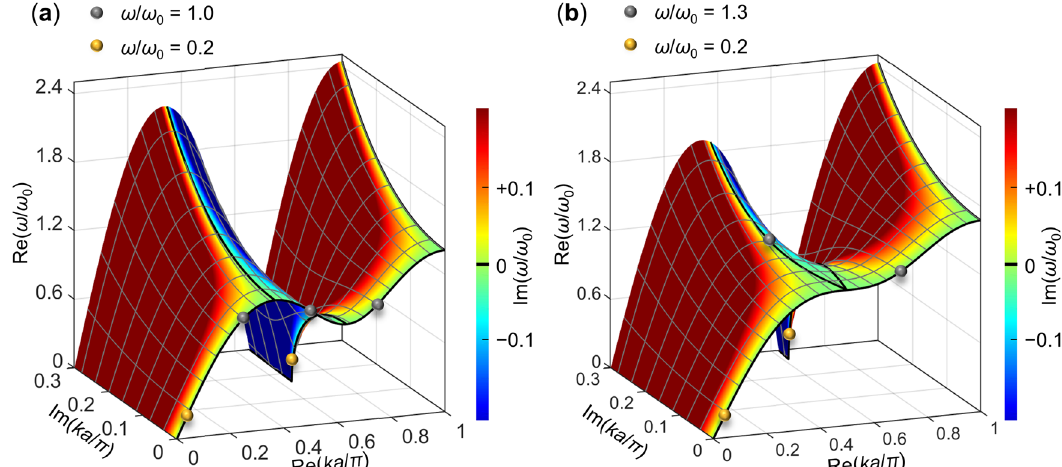
Fig. 2 Dispersion relations of the mass-and-spring model. a Surface plot of real component of frequency ω versus the real and the imaginary components of the wavenumber k following Eq. (5). For the conditions discussed in this paper, the angular frequency ω is purely real. The wavenumber k is also purely real for a Bloch-periodic solution of an in fi nite periodic model. For a fi nite-thickness slab (see Fig. 1b), evanescent modes can play a role and the imaginary part of k is generally not zero. The imaginary part of the complex-valued angular frequency ω is shown by the false-color scale. Only the positive parts of the real and imaginary components of the wavenumber are shown here as the corresponding negative parts can be obtained by mirror symmetry. The four highlighted black lines on the surface lead to purely real angular frequency ω . Among them, one corresponds to purely real wavenumber and the other three correspond to complex wavenumbers in the range of Re ð k Þ > 0. For a normalized frequency of ω = ω 0 ¼ 1 : 0, in between the local maximum and roton minimum, three real wavenumbers (see the three gray dots) can be obtained from the dispersion relation. For ω = ω 0 ¼ 0 : 2 below the roton minimum, a real wavenumber and a pair of complex conjugate wavenumber are obtained (see two yellow dots). Parameters are K 3 = K 1 ¼ 1 : 0 and the normalization ffiffiffiffiffiffiffiffiffiffiffiffiffiffi p frequency is ω 0 ¼ 4 K 1 = m . b Parameters corresponding to the critical case without roton minimum in the dispersion relation, i.e., m ¼ 1 and K 3 = K 1 ¼ 1 = 3. Note that still three solutions for the complex-valued k in the range of Re ð k Þ > 0 occur at a given angular frequency ω